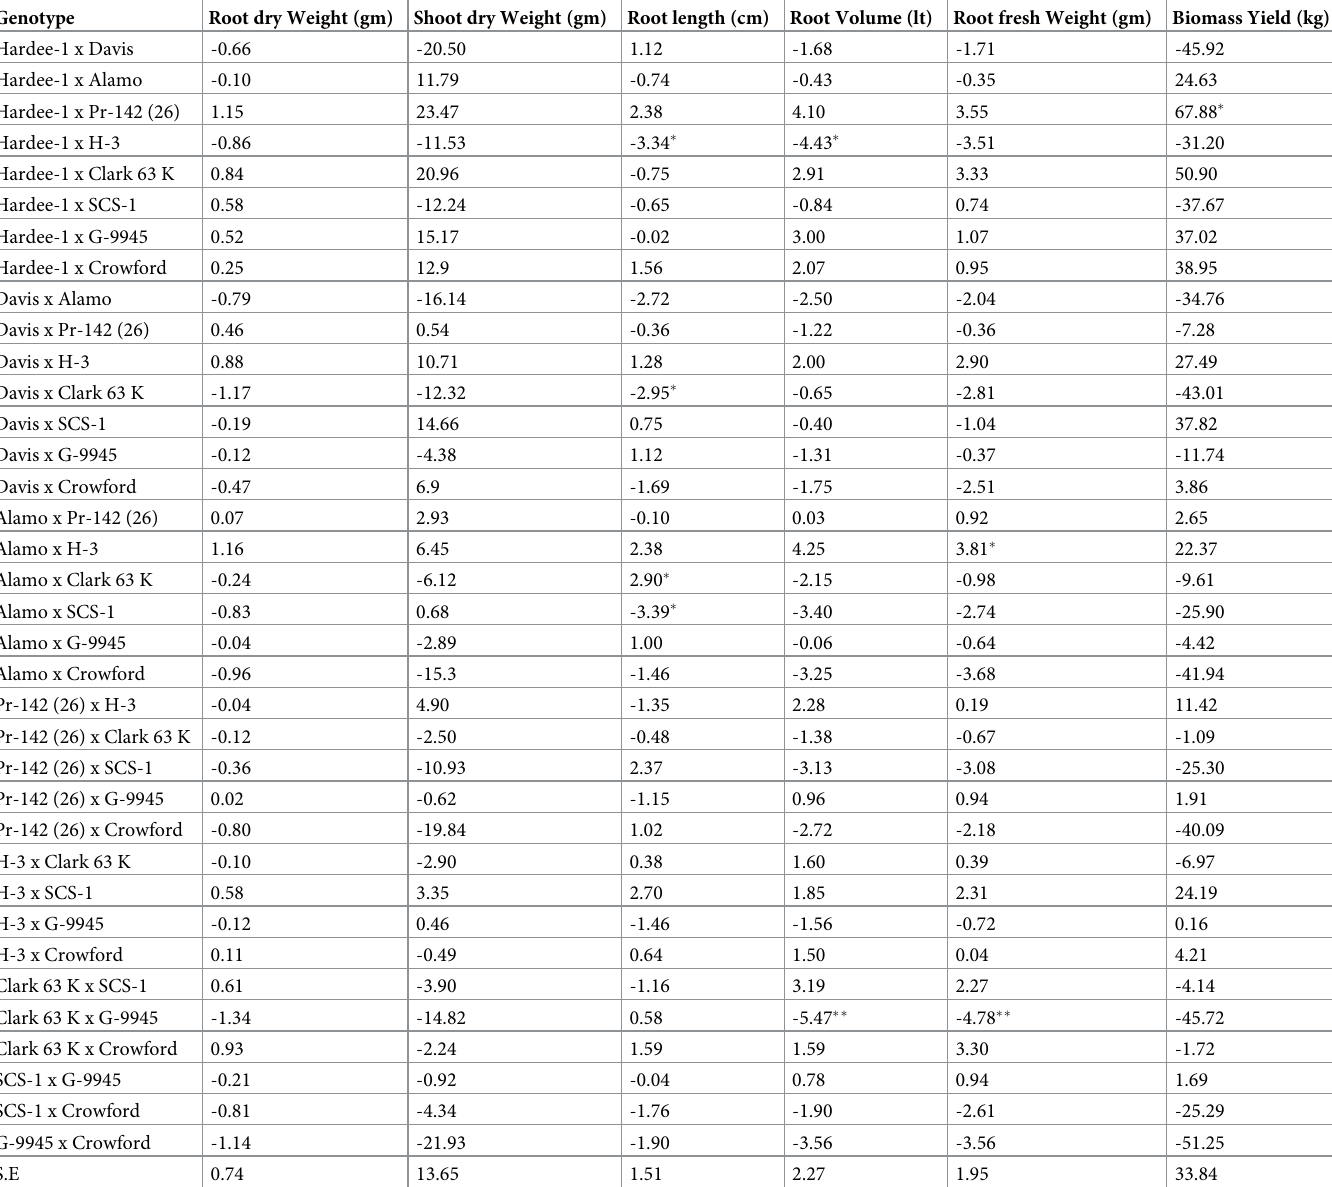
Table 5. Specific combining ability effects of root traits of 45 soybean progeny populations evaluated under low P conditions in Ethiopia.